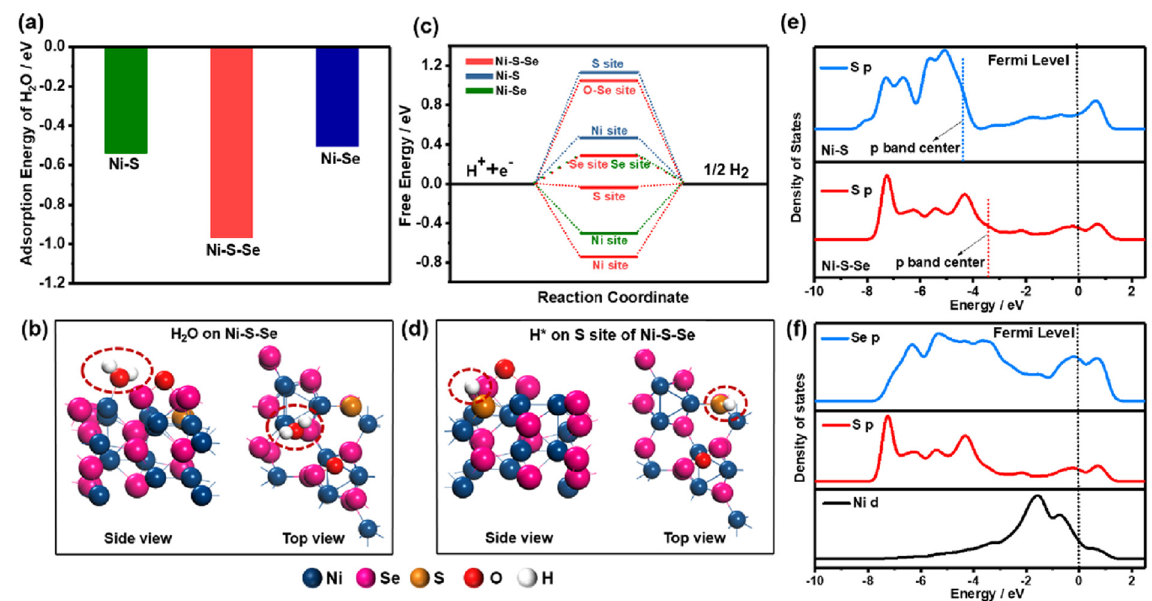
Figure 23. ( a ) Calculated water adsorption energy of Ni-Se, Ni-S and Ni-S-Se systems. ( b ) The calculated configuration of water adsorbed on the Ni-S-Se system (H 2 O in the circle). ( c ) Calculated adsorption free energy of H* on different sites of Ni-Se, Ni-S and Ni-S-Se systems. ( d ) The calculated configuration of H* adsorbed on the Ni-S-Se system (H* in the circle). ( e ) The DOS of sulfur’s p-orbital for Ni-S and Ni-S-Se systems; the p-band center is marked by dotted lines. ( f ) The DOS of Ni d-, S p- and Se p-orbitals of the Ni-S-Se system. Reprinted with permission from Ref. [101]. Xu et al. [102] fabricated unique core–shell in situ-grown Ni 12 P 5 (core) ultrathin amorphous Ni phosphate (shell) nanorod arrays on NF (denoted as Ni 12 P 5 /Ni-Pi/NF) and